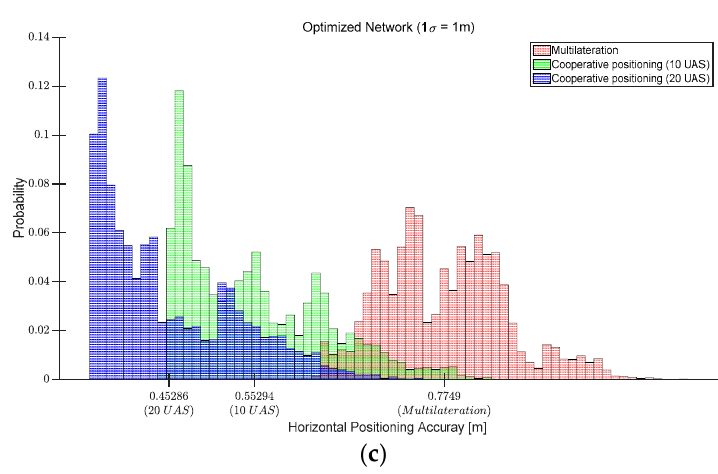
Figure 10. Positioning accuracy distributions of cooperative positioning with 10 and 20 UAS in the three optimized networks: ( a ) optimized network for 3 m positioning accuracy (1 𝜎 ); ( b ) optimized network for 2 m positioning accuracy (1 𝜎 ); ( c ) optimized network for 1 m positioning accuracy (1 𝜎 ).